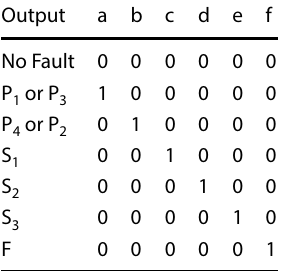
Table 5 Binary adaptation to represent a fault in